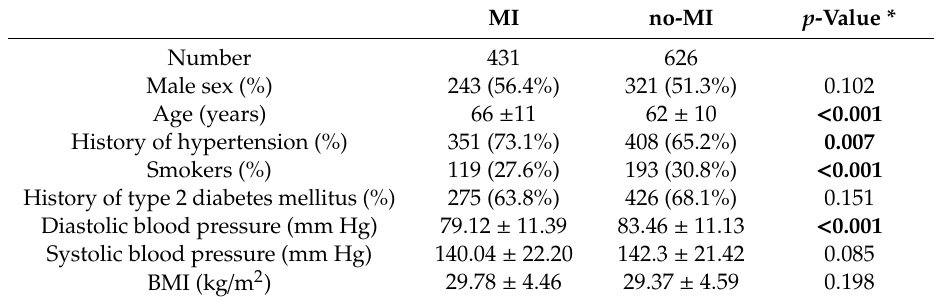
Table 2. Prevalence of cardiovascular risk factors of myocardial infarction (MI) and no-MI participants.